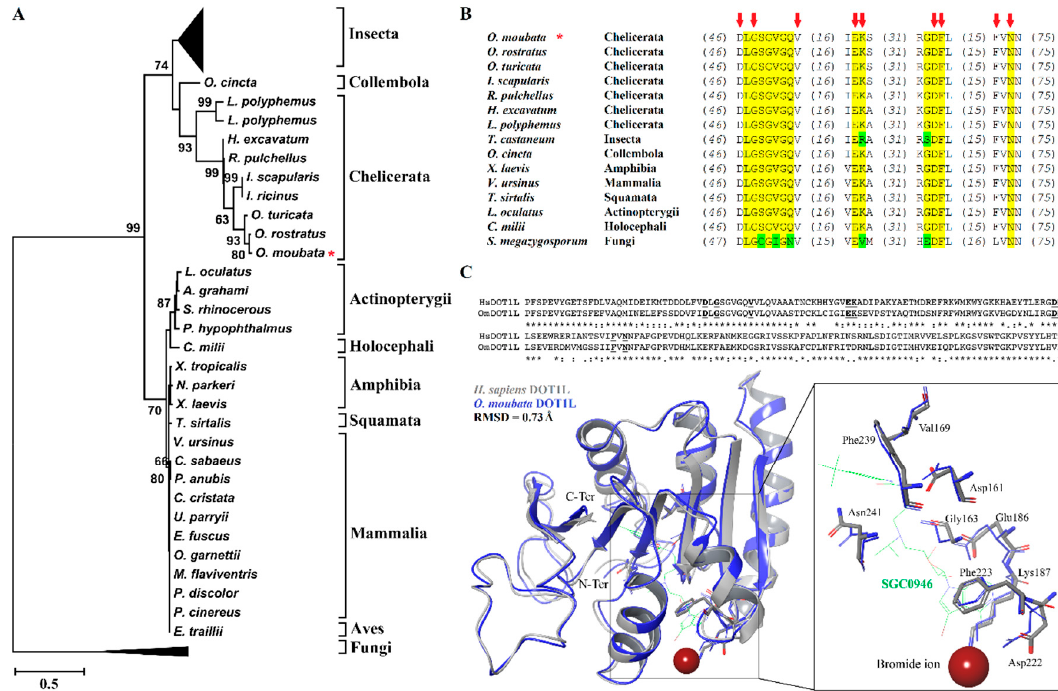
Figure 1. Phylogenetic and structural characterization of OmDOT1L. The evolutionary history of DOT1L was inferred by using the maximum likelihood method based on the LG matrix-based model. The tree with the highest log likelihood ( − 5402.58) is shown. Initial trees for the heuristic search were obtained automatically by applying neighbor-joining and BioNJ algorithms to a matrix of pairwise distances estimated using a LG model, and then selecting the topology with superior log likelihood value. The tree is drawn to scale, with branch lengths measured in the number of substitutions per site. The analysis involved 77 amino acid sequences and there were a total of 201 gap-free positions in the final dataset. Numerals close to the branches are bootstrap values. For display simplification, clusters including Insecta and Fungi DOTL1 sequences were collapsed. The position of OmDOT1L is shown with a red asterisk (*). A full version of the tree is available as Supplementary Figure S1 ( A ). Multiple sequence alignment showing conserved (labeled in yellow) and less conserved (labeled in green) residues of S-adenosylmethionine (SAM) binding sites across DOT1L orthologues and the amino acid positions identified to interact with SGC0946 (red arrows). The sequence of OmDOT1L is shown with a red asterisk (*) ( B ). The alignment shows the catalytic domain of DOT1L from H. sapiens (Hs) and O. moubata (Om) with SGC0946 interacting residues underlined in bold. The superposition of the two DOT1L structures (Hs, grey and Om, blue) with the bromide ion (amber sphere), SGC0946 (green) and interacting residues shown. The amino-terminus (N-Ter) and carboxyl-terminus (C-Ter) are labeled. The inset shows a closeup of the active site with the bromide ion, SGC0946 and the interacting residues labeled ( C ).